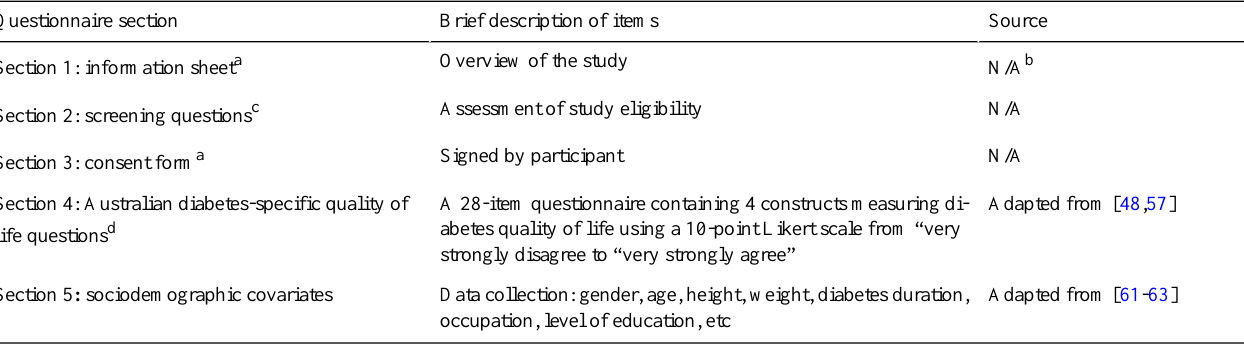
Table 1. Study phase 1: online Australian diabetes-specific quality of life questionnaire completed by adults with type 1 diabetes mellitus